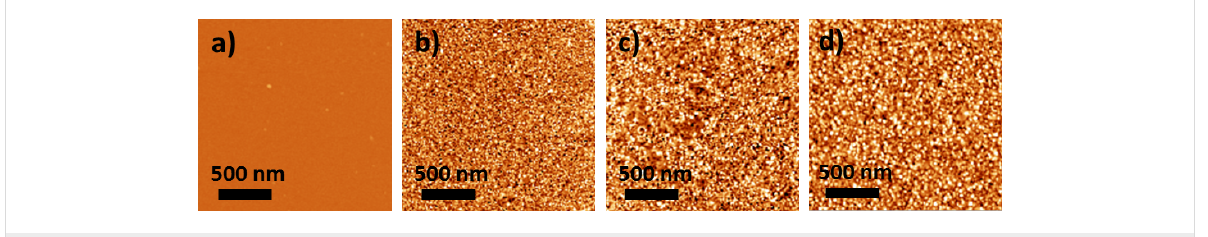
Figure 1: AFM images of a) the Si substrate b) Au10 , c) Au20 and d) Au50 .